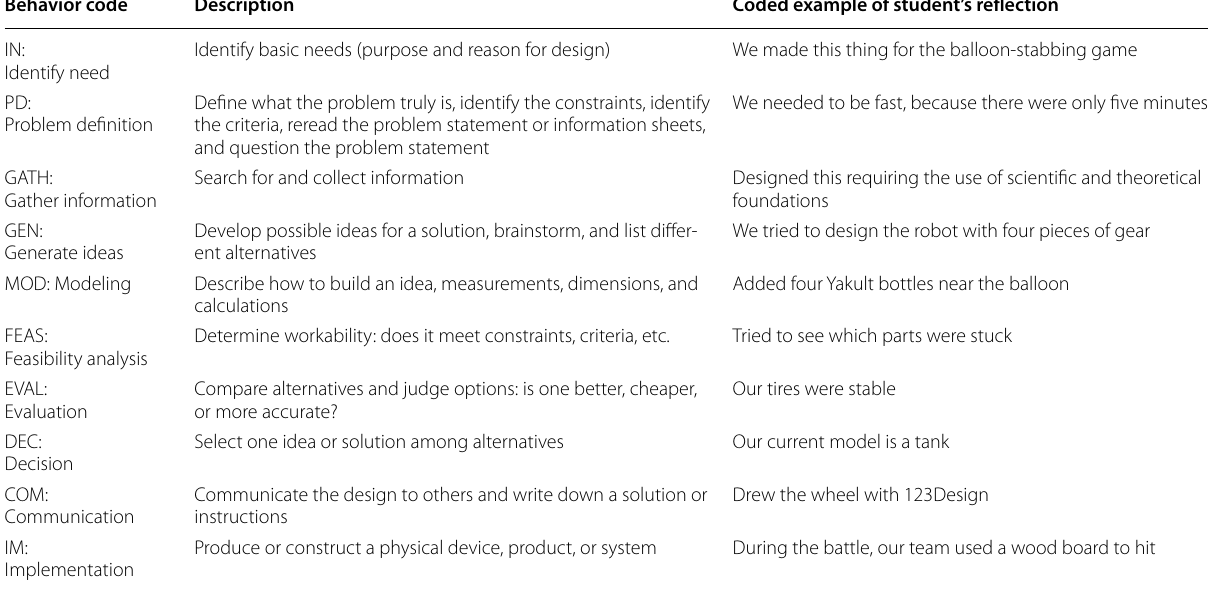
Table 2 Coding scheme of engineering design behavior Behavior code Description Coded example of student’s reflection